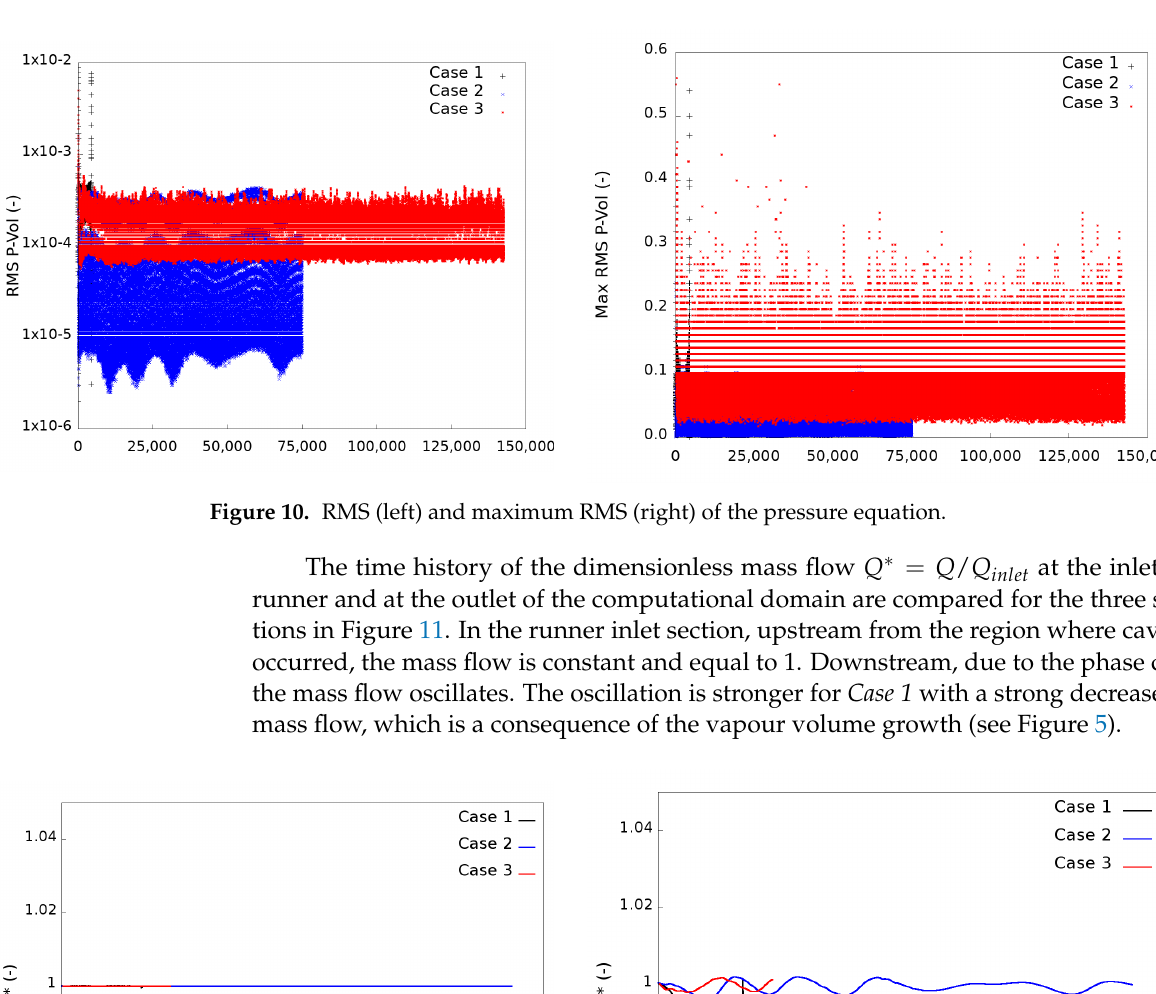
runner and at the outlet of the computational domain are compared for the three simula-